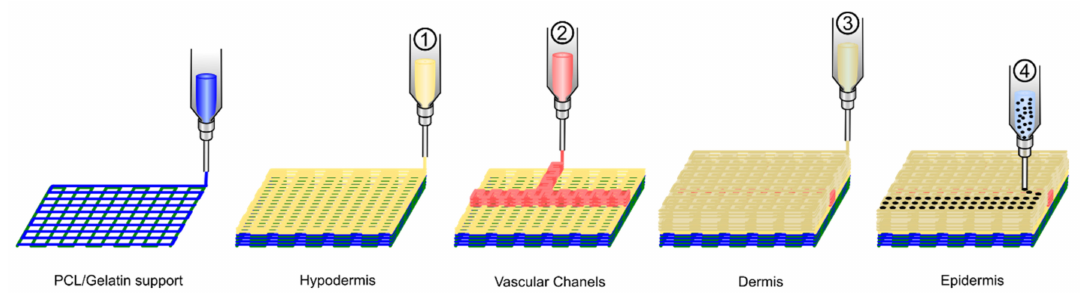
Figure 8. Schematic diagram exhibiting the 3D cell printing process for fabrication of a 3D full-thickness skin